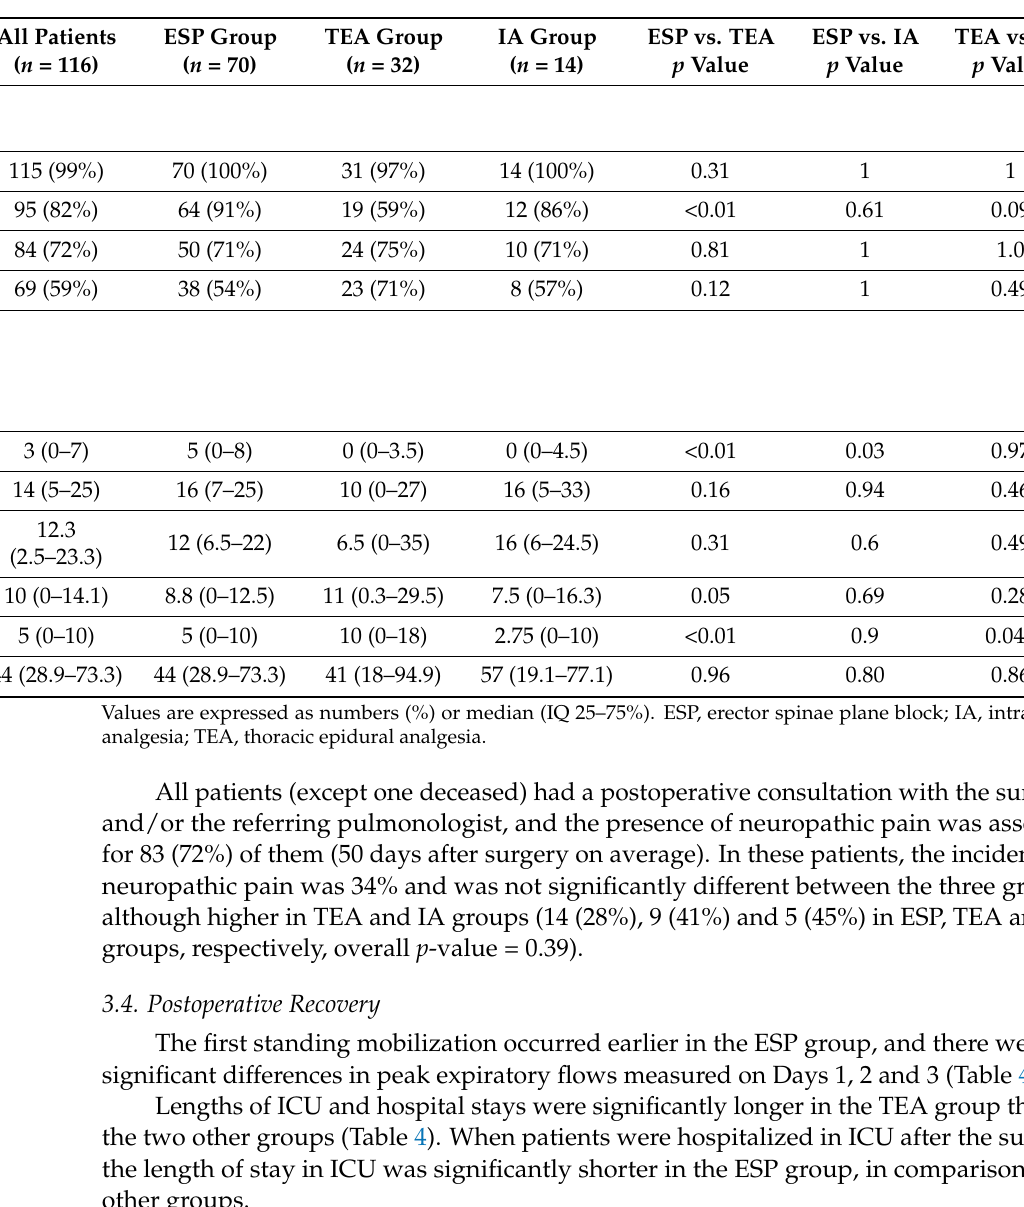
Table 3. Postoperative pain and opioid